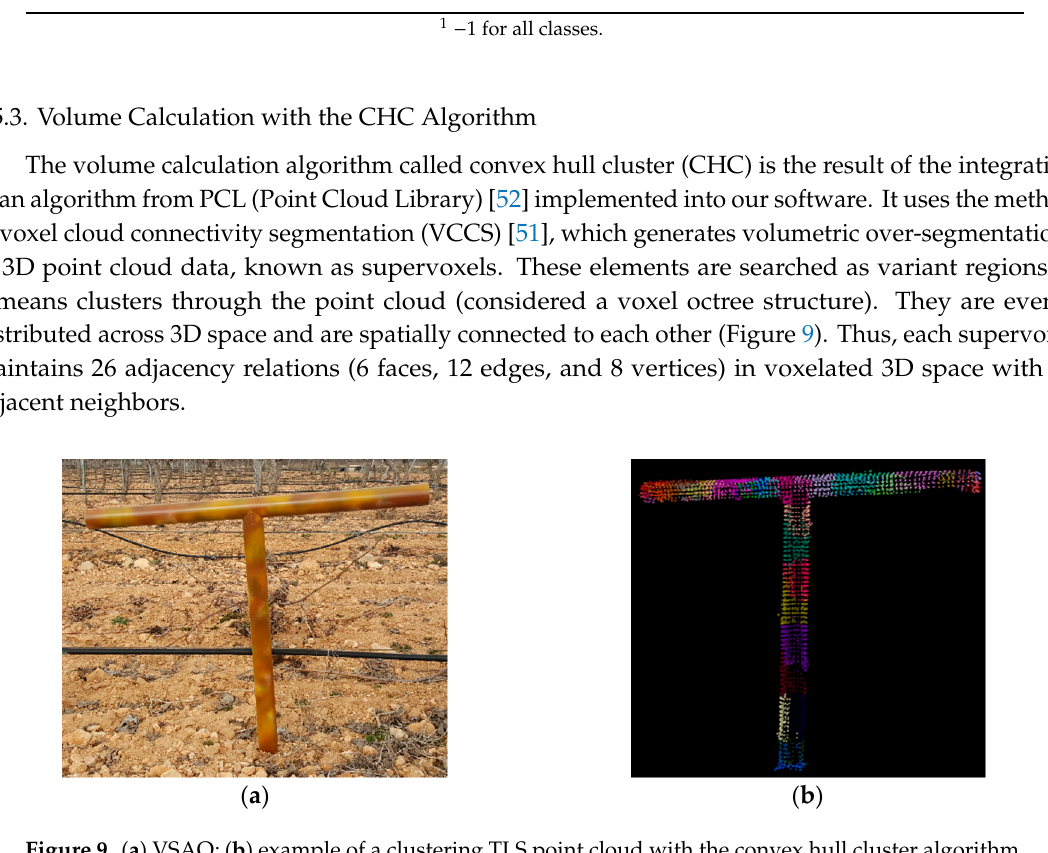
Table 6. List of the editable parameters of the convex hull cluster.